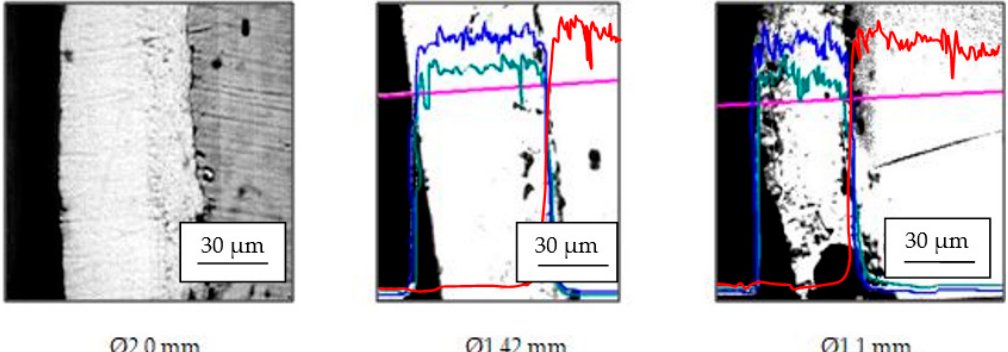
Figure 7. The structure of the anticorrosive layer (deposited on variant 2) on the steel wire surface; the compositional profiles of Zn (blue), Al (green), and Fe (red) along its drawing on analysis line (purple).